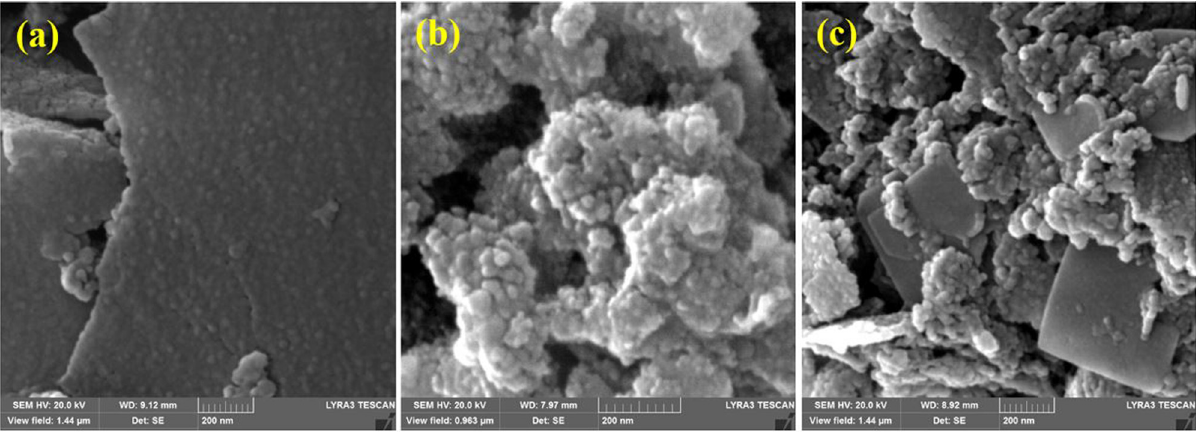
Figure 3: FE - SEM images of pure g - C 3 N 4 ( a ) , pure NiO ( b ) , and n - NiO@g - C 3 N 4 ( c ) .